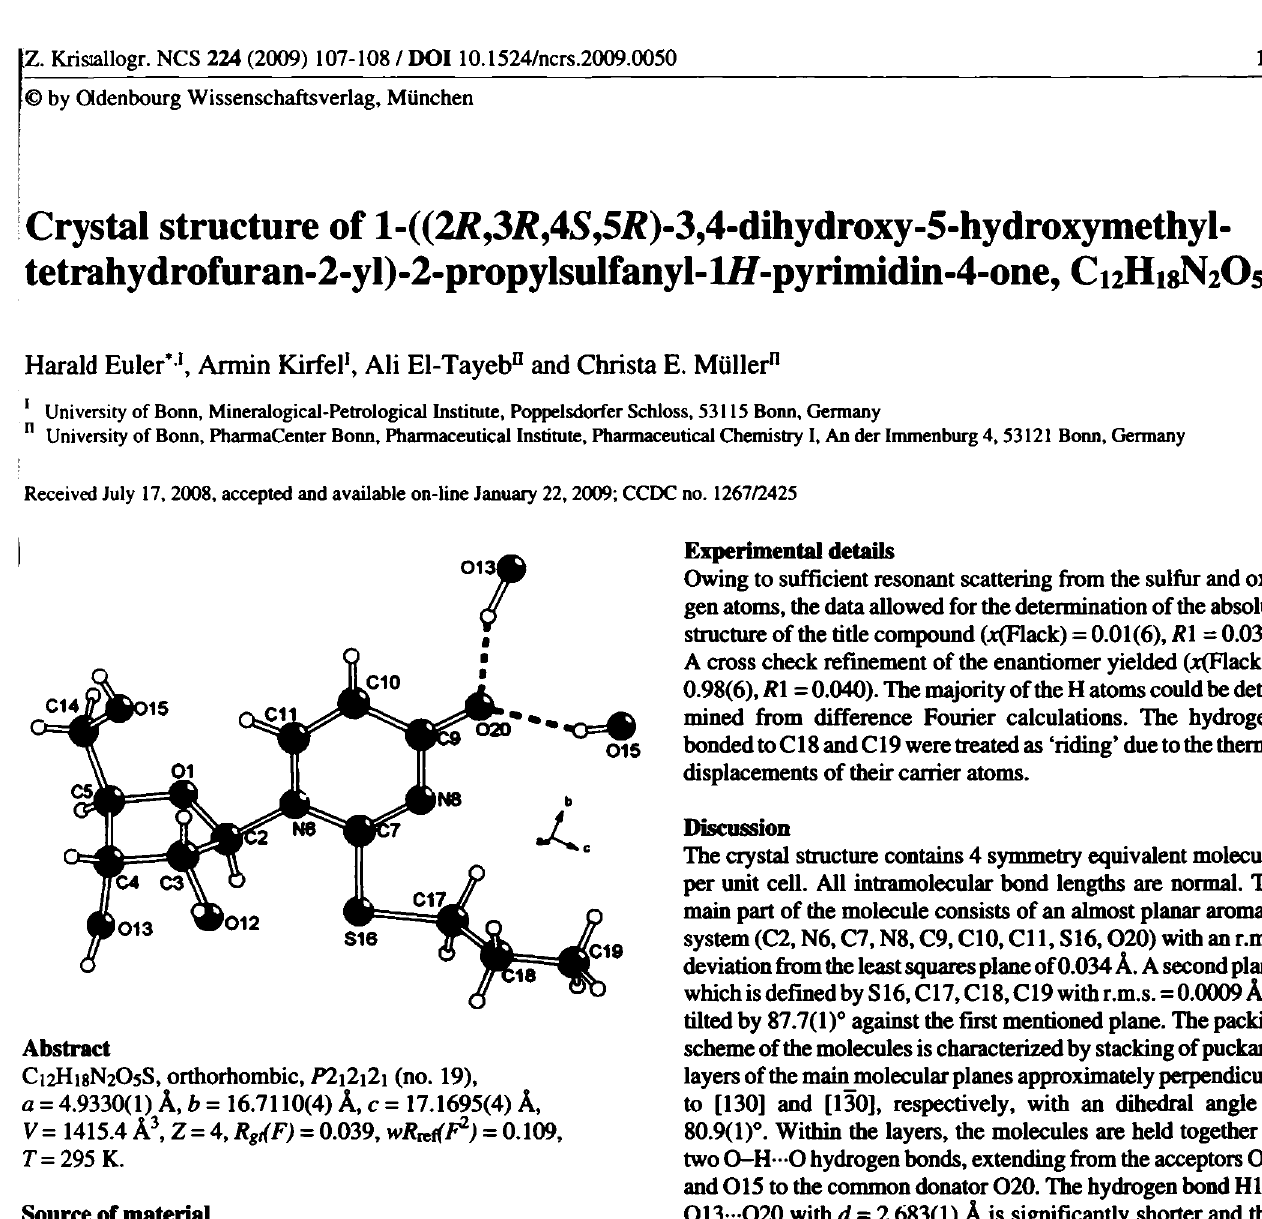
Table 1. Data collection and handling.